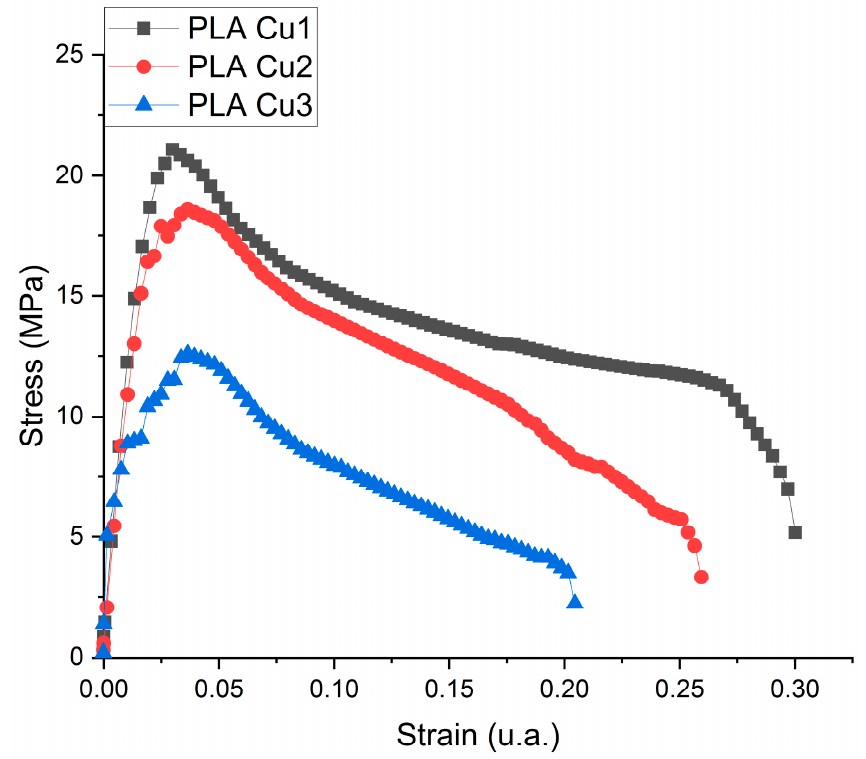
Figure 7. Tensile deformation curve of the PLA-Cu composite sample. Table 3. The results obtained for tensile strength tests.